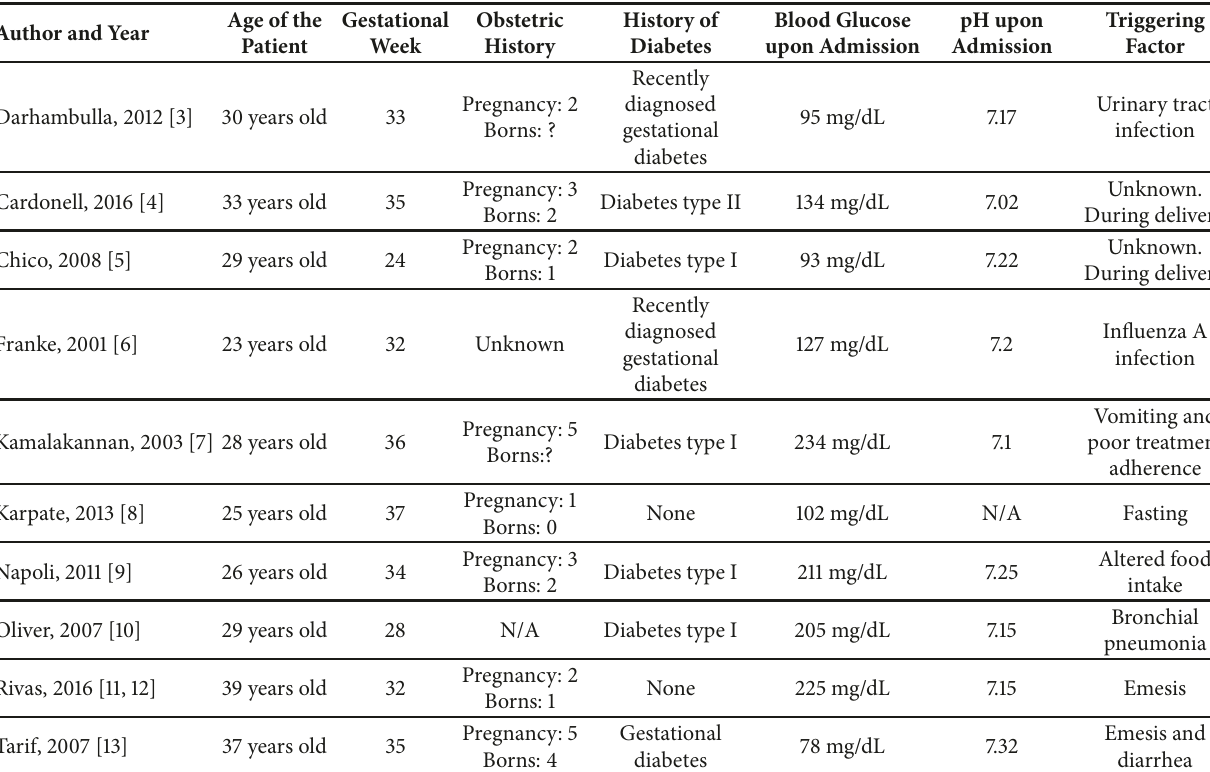
Table 3: Cases of euglycemic DKA in pregnancy reported in